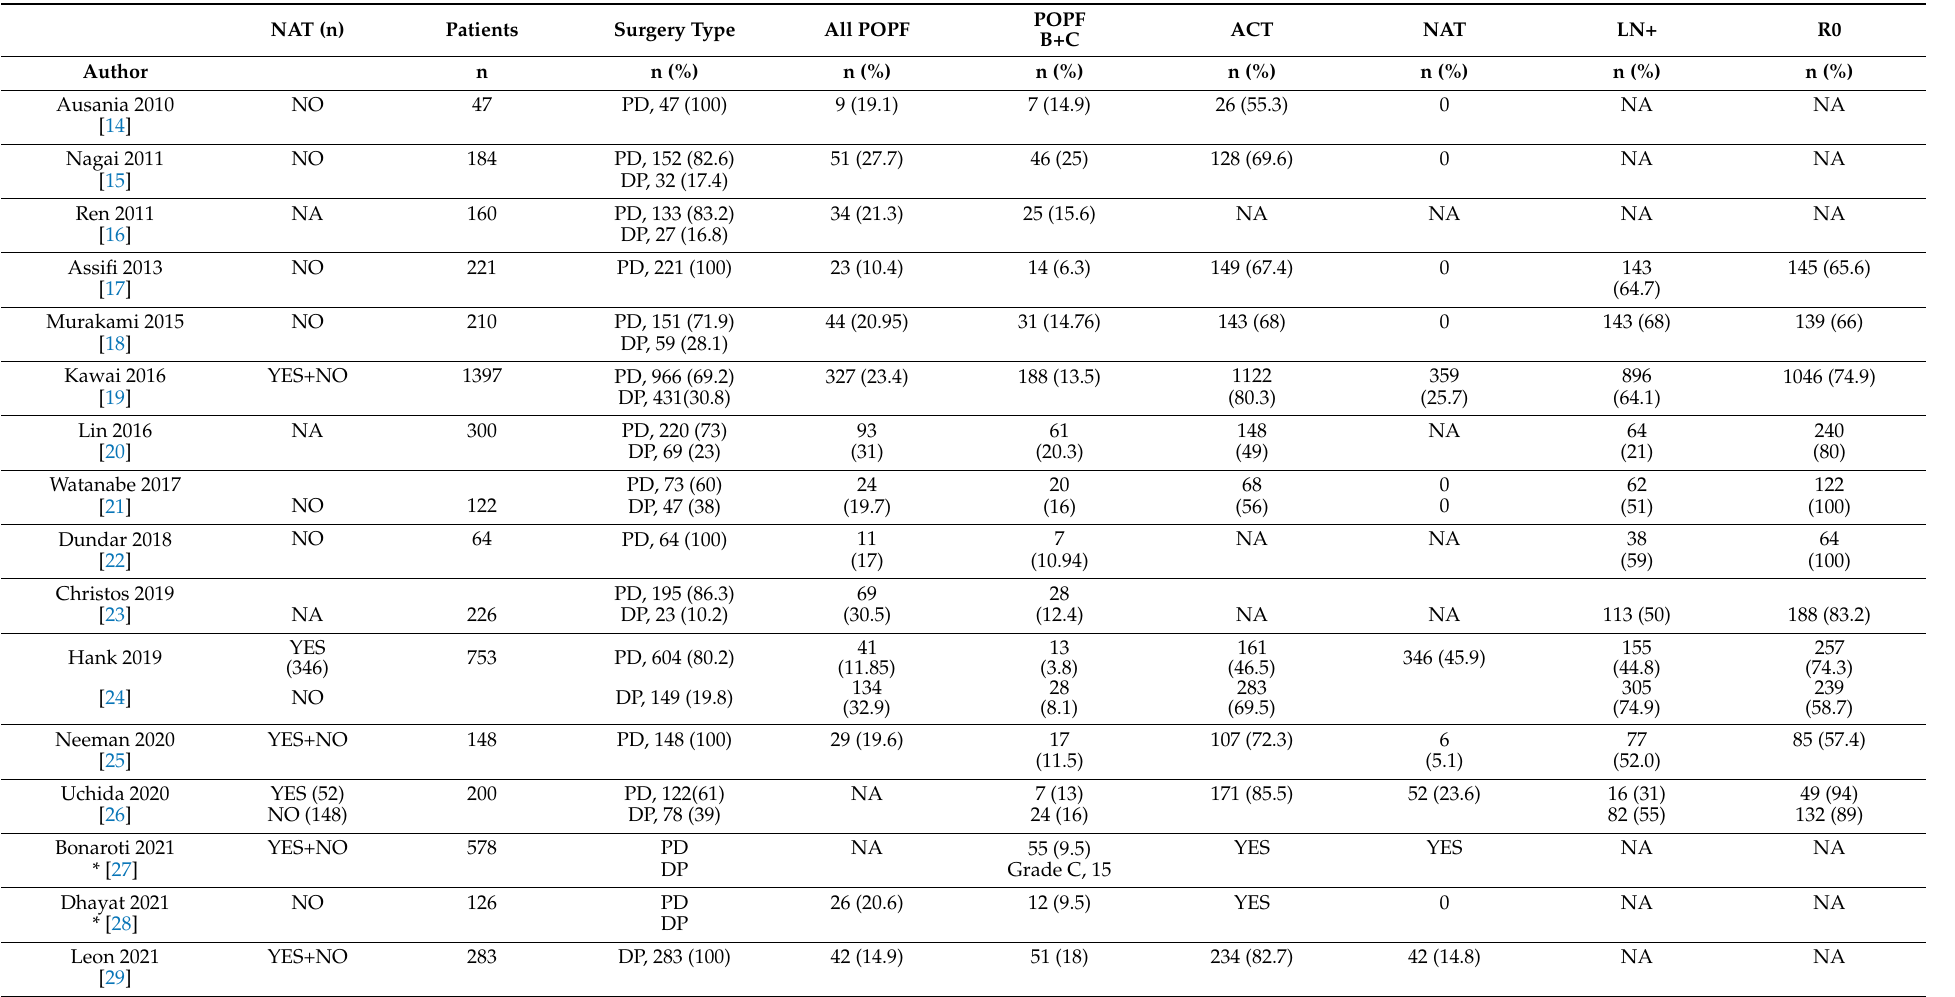
Table 1. General characteristics of the studies, the patients, and their tumors considered in the systematic